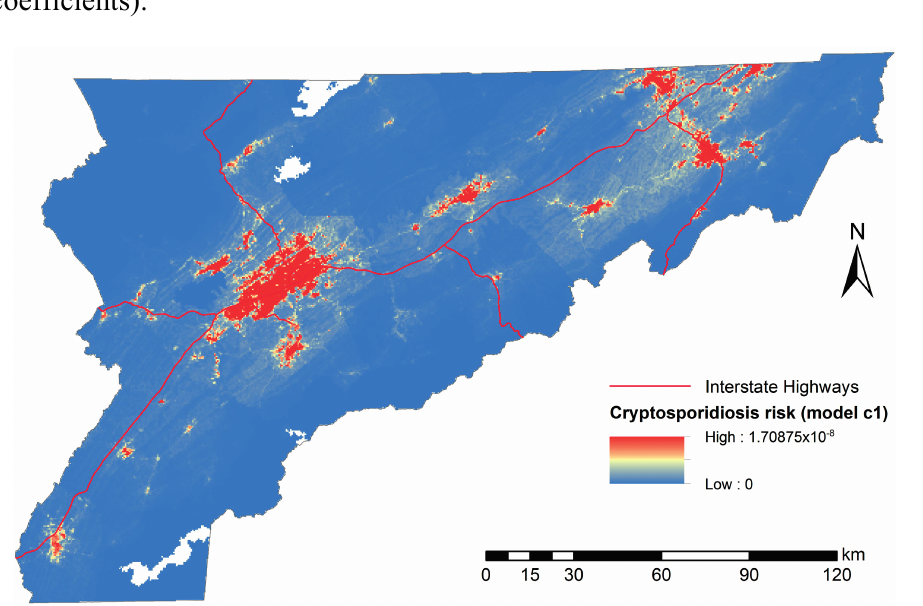
Figure 3. Spatial logistic regression model (C1) risk map for cryptosporidiosis (see Table 2 for the